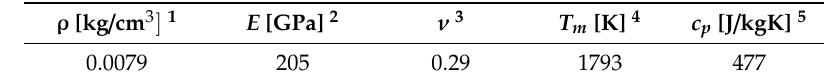
Table 3. NICRO 12.1 properties.